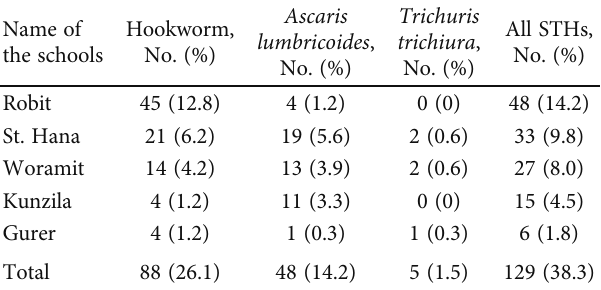
Table 3: Prevalence of soil-transmitted helminth (STH) infection among the selected primary schools in and around Lake